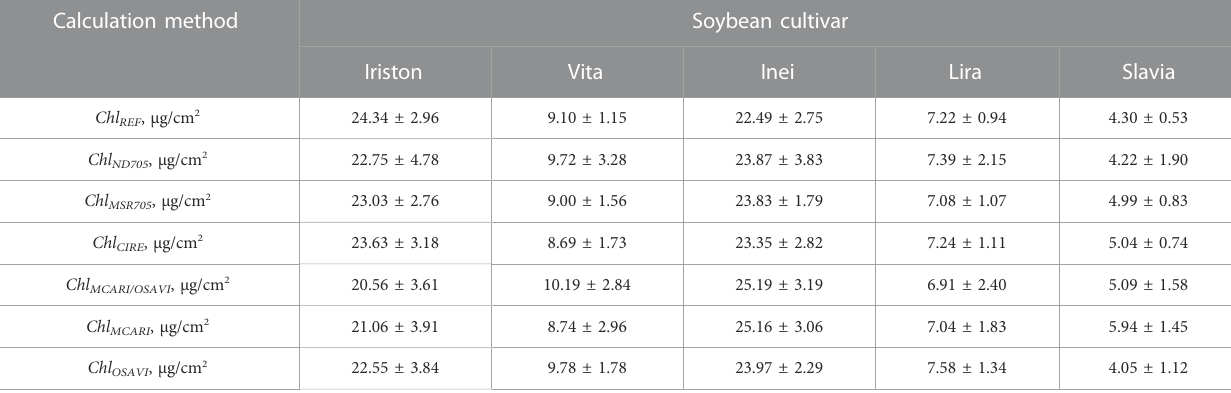
TABLE 6 Average chlorophyll concentrations obtained from reference spectrophotometric ( Chl REF ) and CI-based ( Chl INDEX ) measurements. Calculation